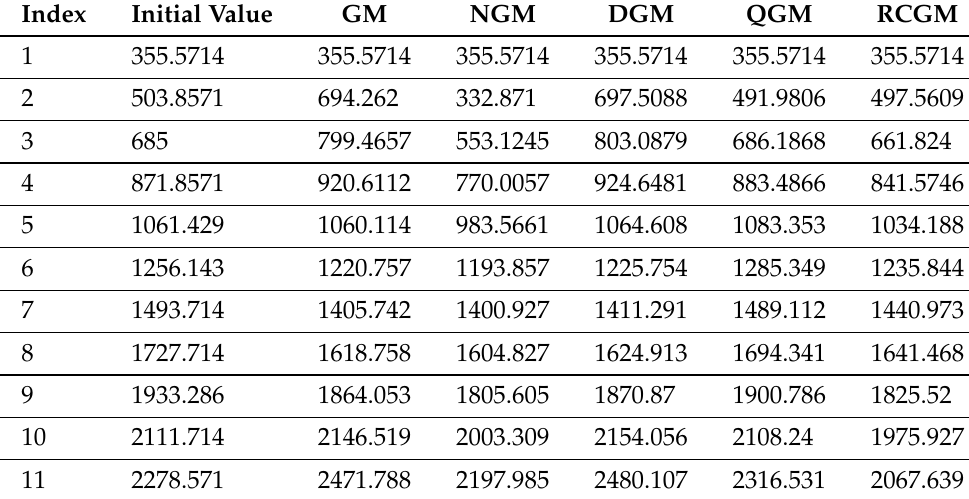
Table 2. Predicted values from Delhi data Model I.